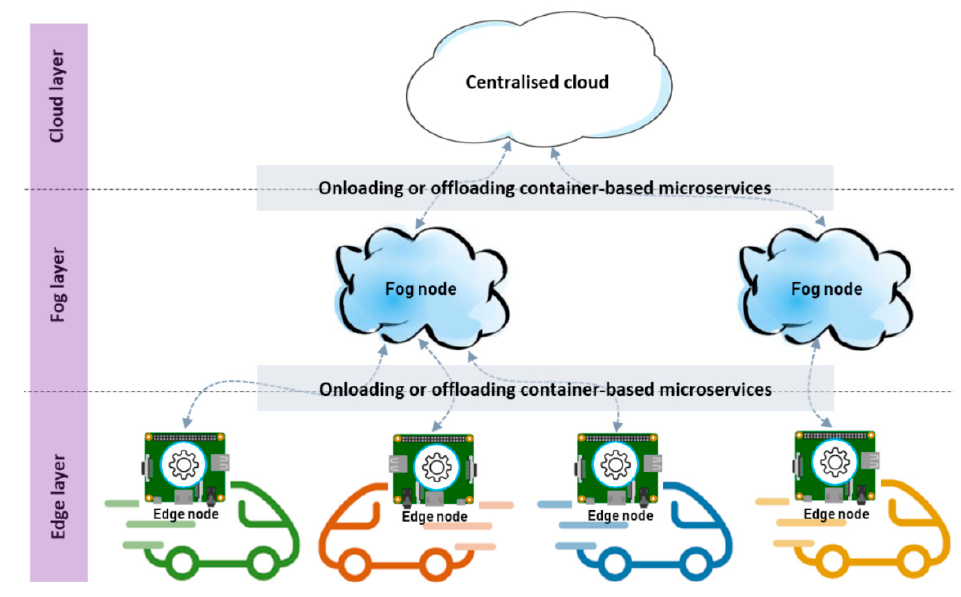
Figure 2. Onloading or offloading Microservices between different layers (Edge, Fog and Cloud) in the proposed capillary distributed computing architecture.